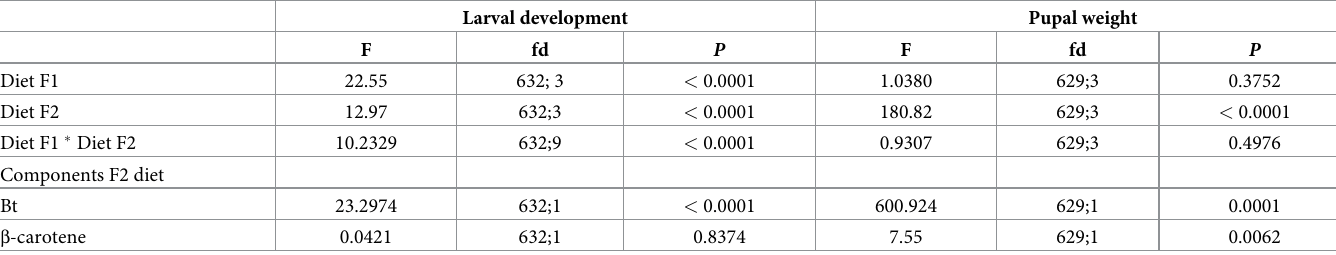
Table 3. Statistics of the two-way ANOVA of larval development and pupal weight of Helicoverpa armigera F2. Larval development Pupal